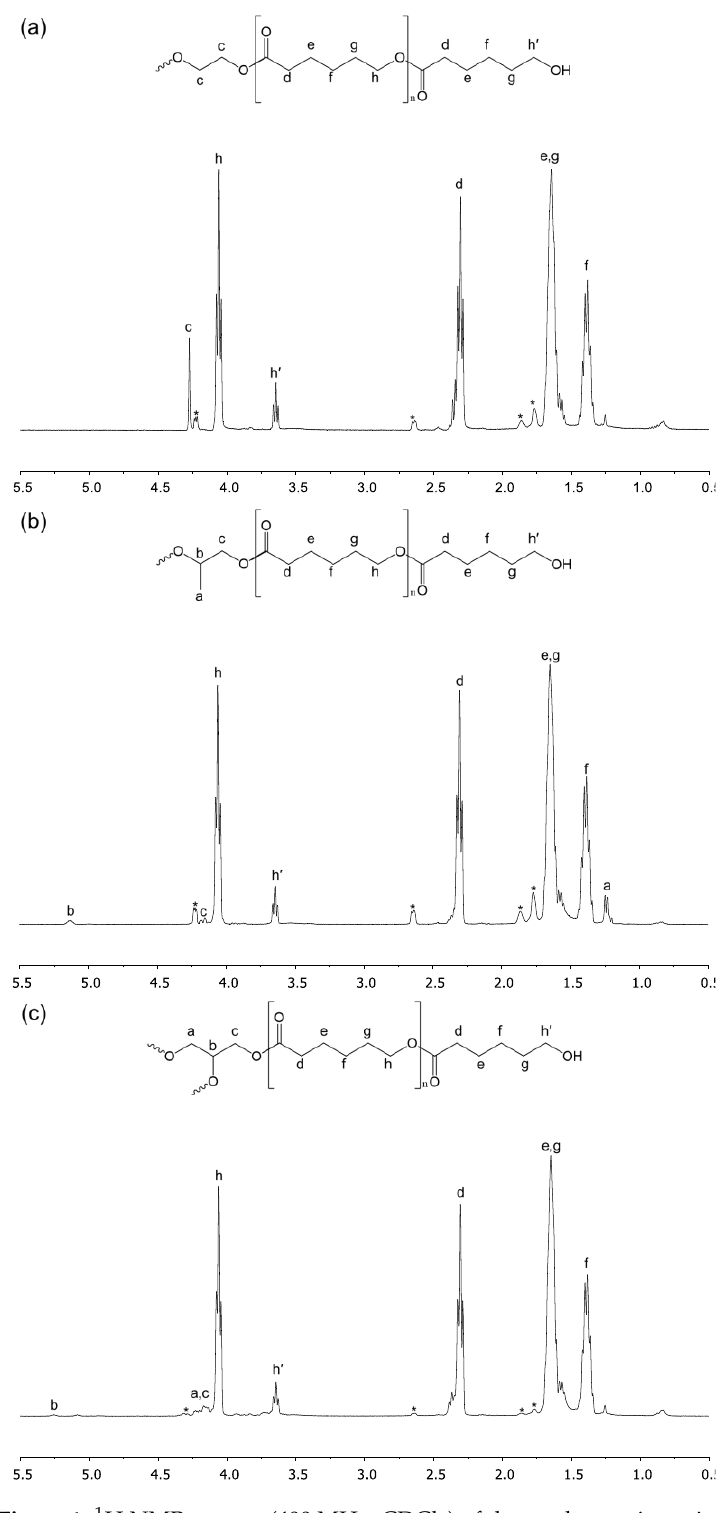
Figure 1. 1 H NMR spectra (400 MHz, CDCl 3 ) of the crude reaction mixture of CL polymerization using various initiators: ( a ) EG, ( b ) PG, and ( c ) GL (runs 5, 8, and 9 of Table 2). * denotes the residual monomer signals.